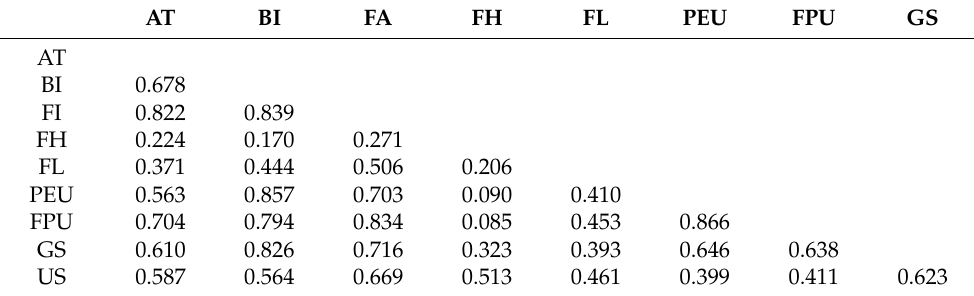
Table 5. Discriminant validity heterotrait-monotrait (HTMT) values.